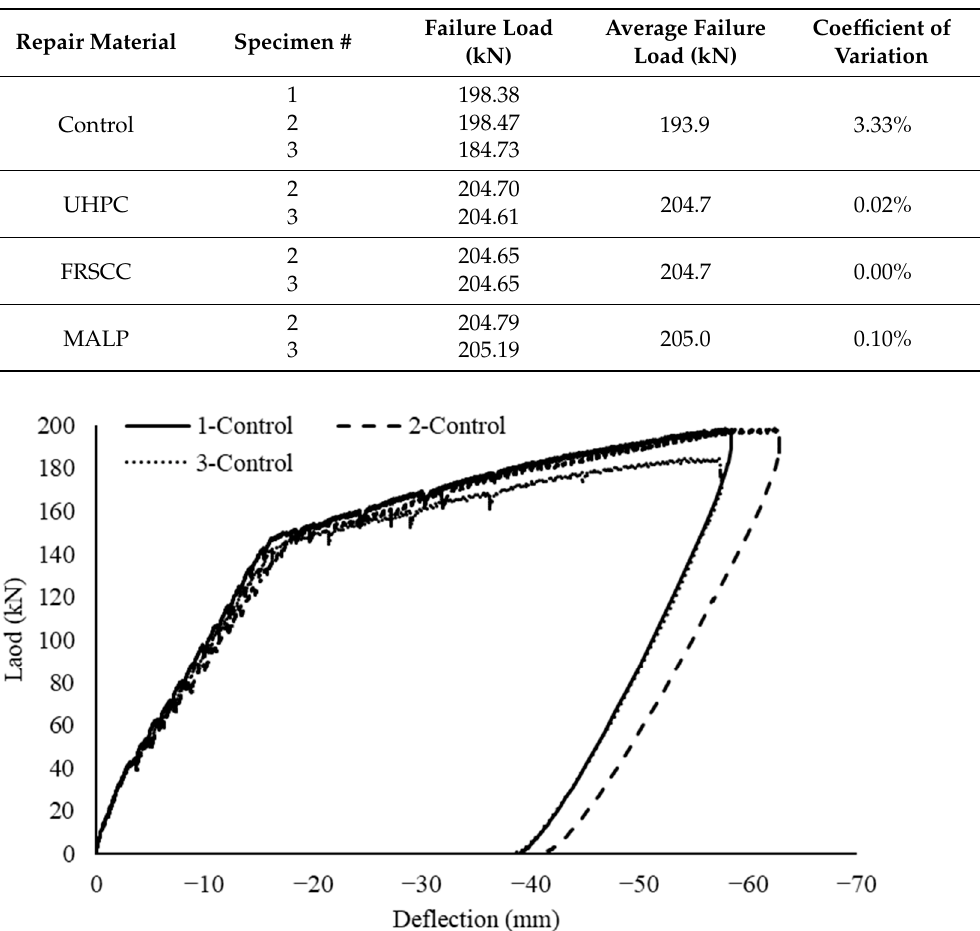
Figure 11. Load vs. deflection plot for control connected girder specimens.